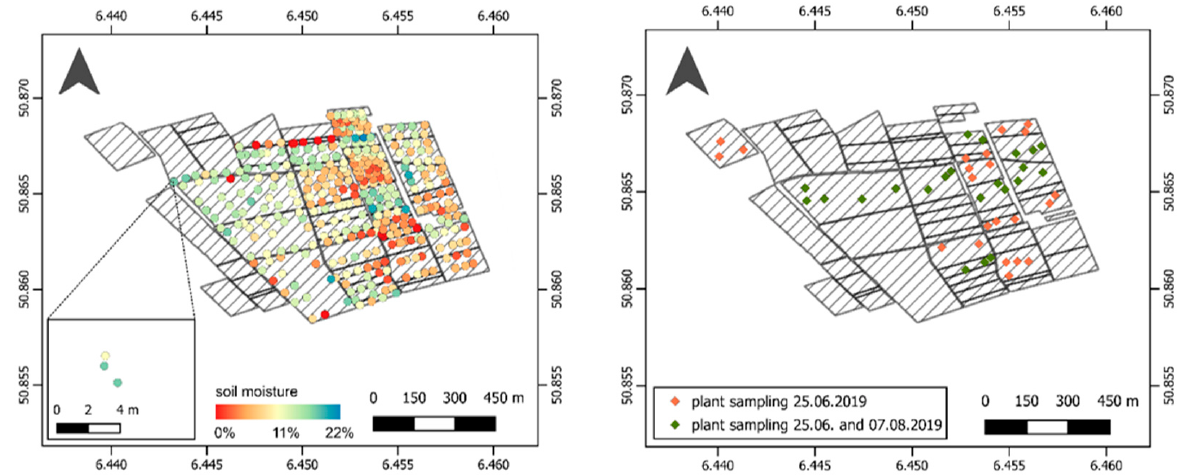
Figure 6. Soil moisture sampling points for the 21 June (left) and plant sampling points for the 25 June and 7 August (right).